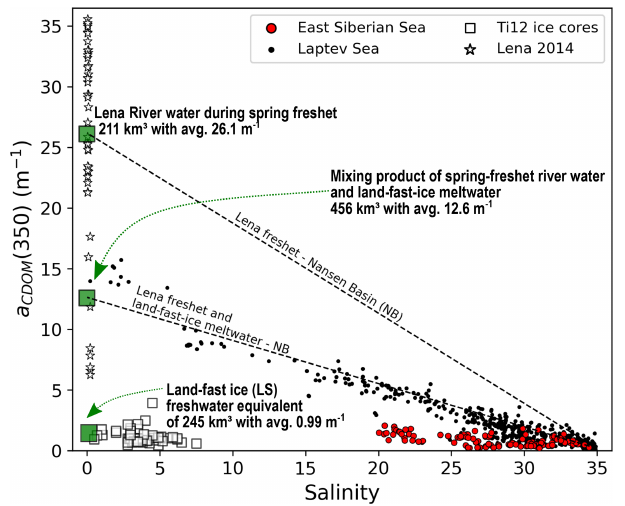
Figure 7. Salinity and a CDOM 350 measured in land-fast ice from the LS (squares), Lena River water during the spring freshet in May/June 2014 (stars), and marine waters from the LS (black dots) and ESS (red dots). The dashed lines represent the theoretical con- servative mixing lines between the spring-freshet river water (flow- weighted CDOM absorption) and the Nansen Basin (NB) seawa- ter, as well as between the mixing product of the spring-freshet river water with the land ice meltwater (MIX) and the seawater. The green squares indicate a CDOM 350 endmember values of the spring-freshet river water and land-fast ice meltwater (freshwater equivalent), as well as the calculated endmember value for the mix- ing product of the two